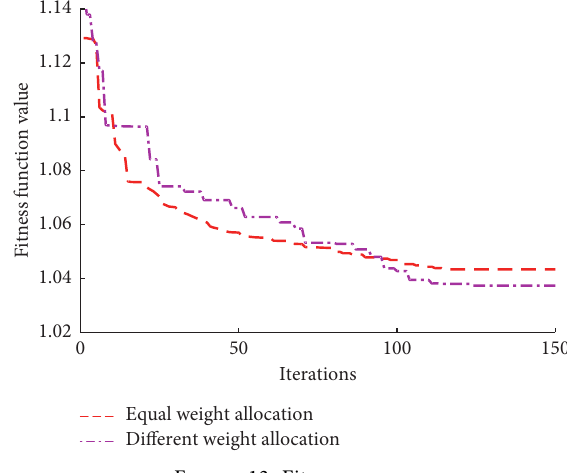
Figure 13: Fitness